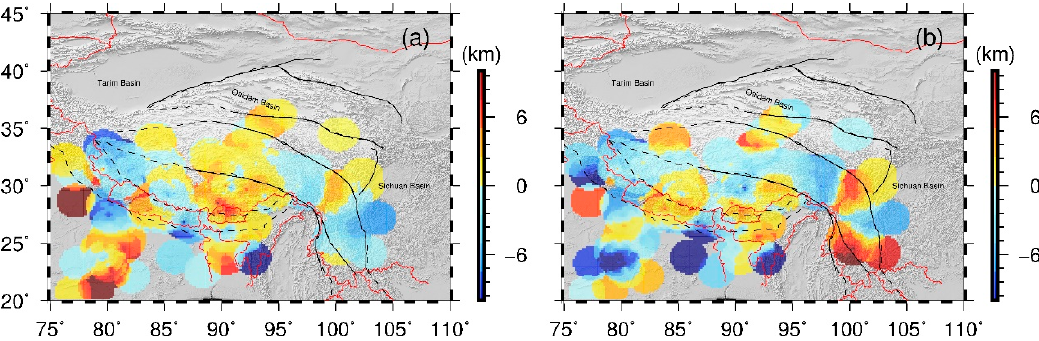
Figure 6. Crustal thickness from ( a ) Singh et al. (2017) [59], ( b ) CRUST1.0, ( c ) MJ.